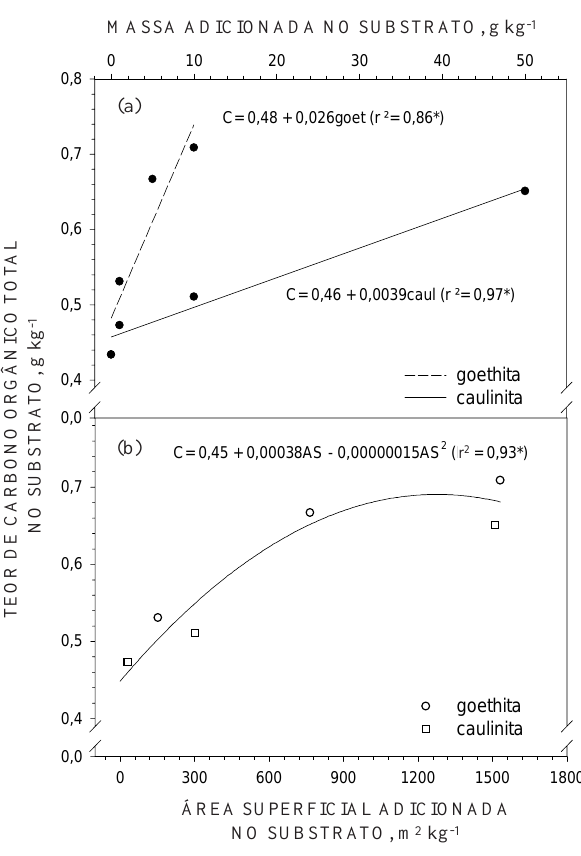
Figura 4. Teor de carbono orgânico total nos substratos, após 200 dias da adição de palha de milho, considerando a massa de caulinita natural (caul) ou goethita sintética (goet) (a) e da área superficial (AS) (b) adicionada nos substratos inorgânicos (* P < 0,05 e NS não-